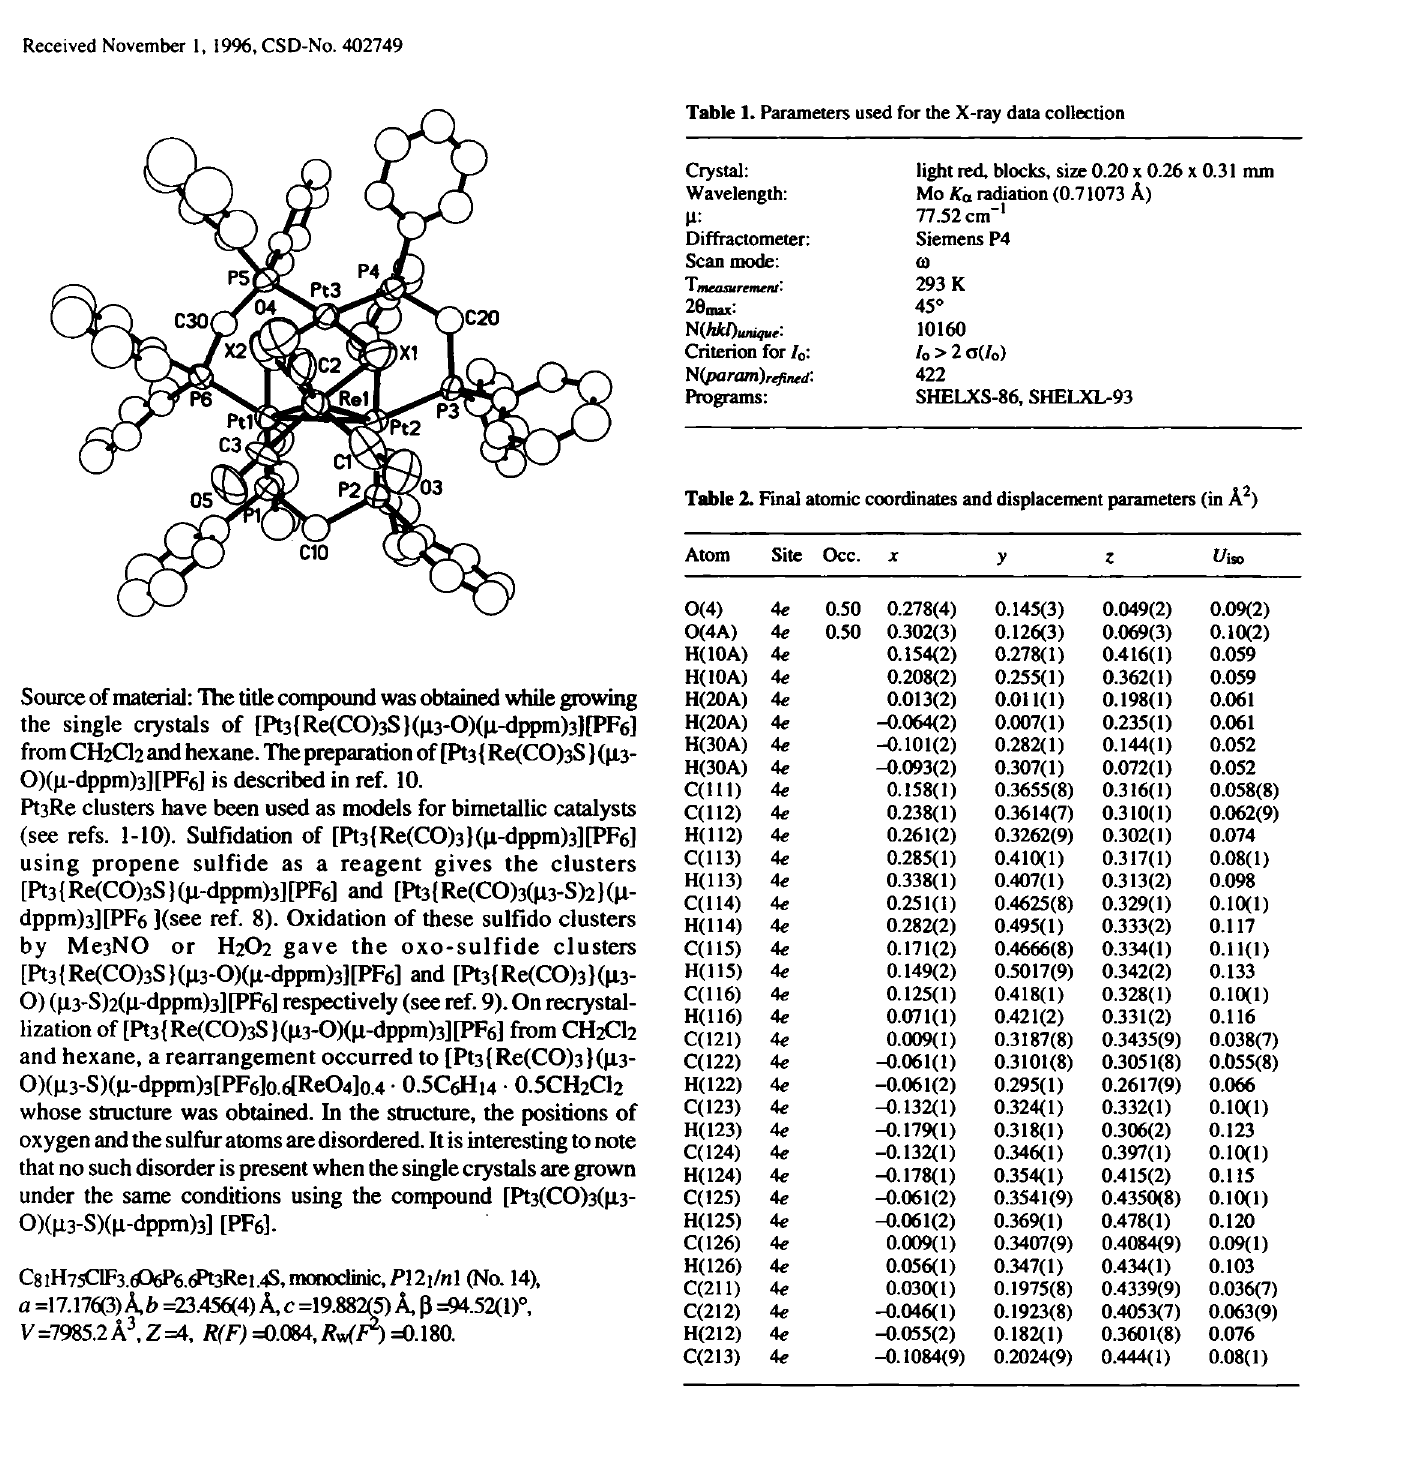
Table 1. Parameters used for the X-ray data collection